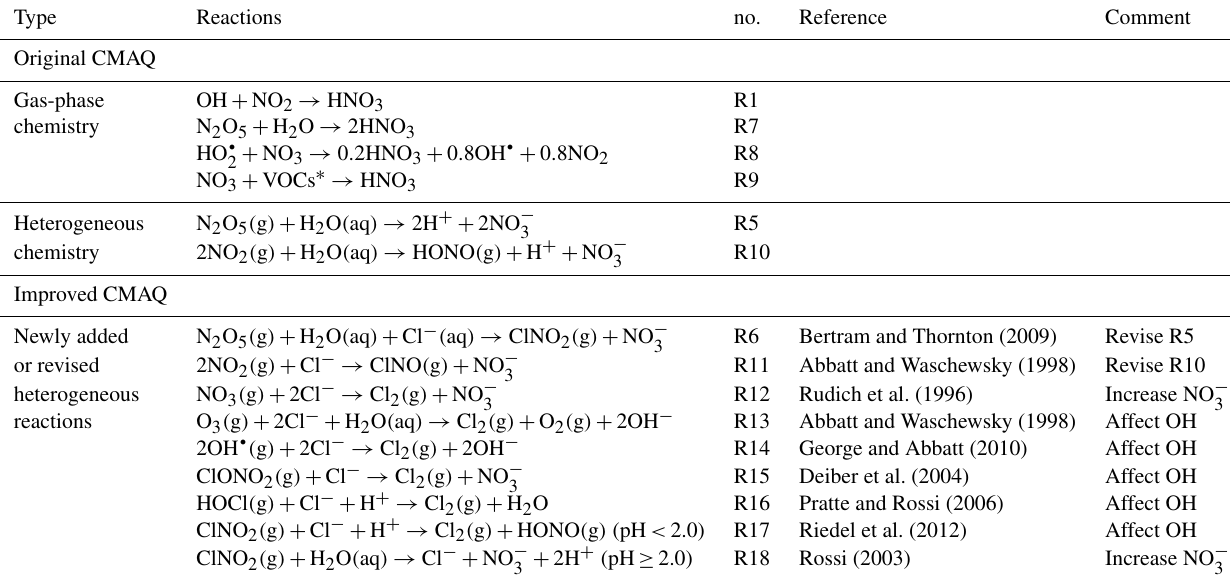
Table 2. Major gas-phase and heterogeneous pathway of producing nitrate in original CMAQ, and newly added or revised heterogeneous reactions in improved